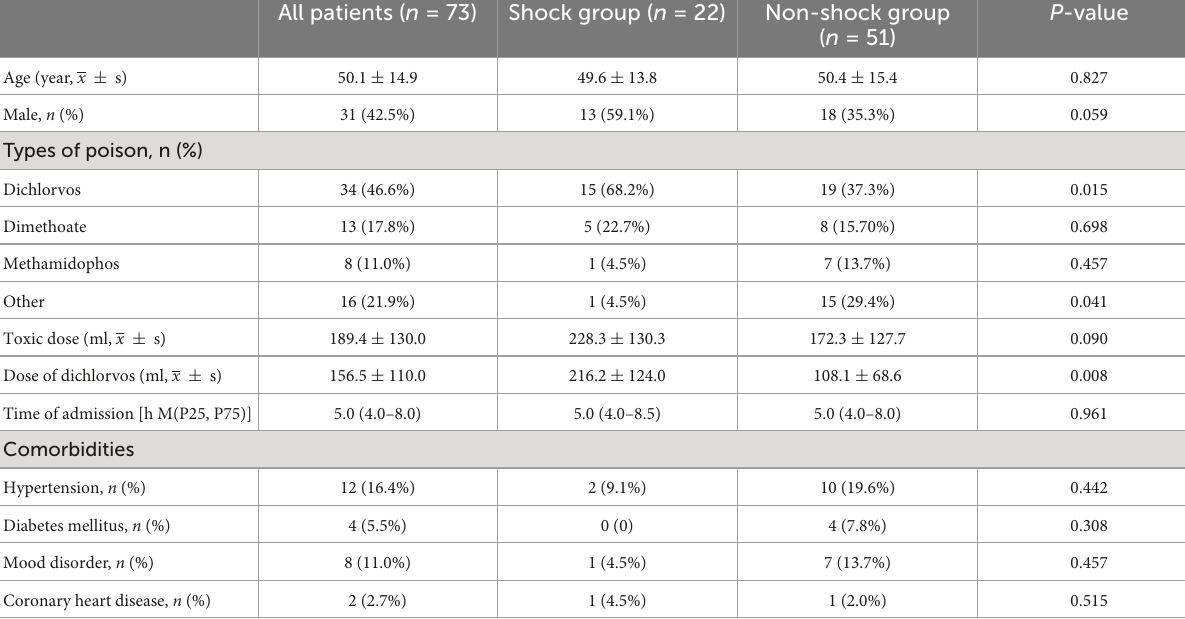
TABLE 1 General clinical data of patients with organophosphorus poisoning-induced shock.